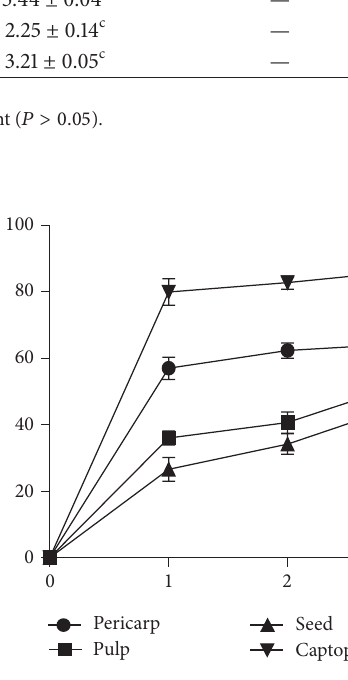
Figure 3: Angiotensin-I converting enzyme (ACE) inhibition by extracts from Soursop fruit part and captopril. The concentrations of the extract for the plot are 0.00, 0.05, 0.10, 0.20, and 0.25 mg/mL. The concentrations of captopril used for the plot are 0.00, 1.50, 2.50, 5.00, and 6.50 𝜇 g/mL. Values represent mean of standard deviation of triplicate readings.